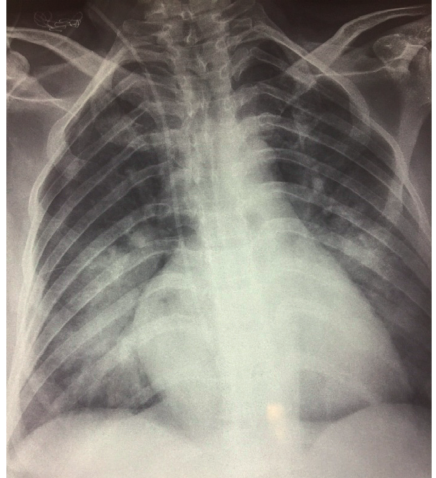
Figure 1: Admission Chest X-ray showing bilateral infiltrates.